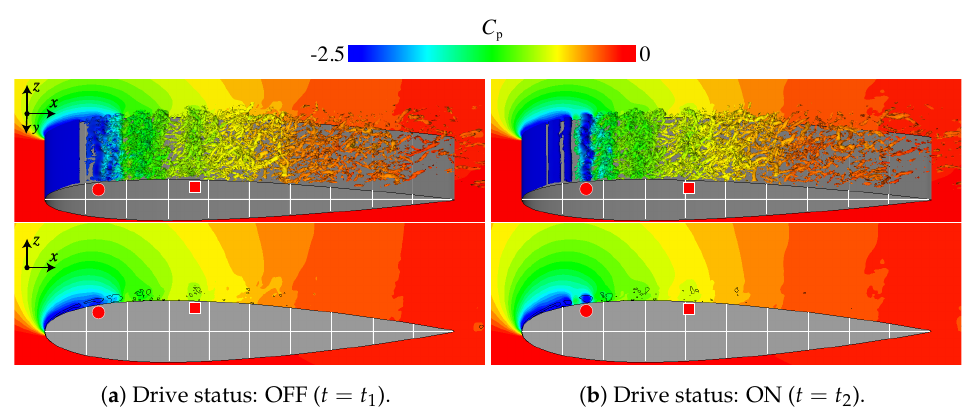
Figure 11. Instantaneous flow field (top, Q = 1250) and spanwise-averaged flow field (bottom, Q = 250) with isosurfaces of the second invariant of the velocity gradient tensor ( Q ) colored based on C p in FTM4 at α = 12. The red circles and squares denote the locations of representative spanwise vortices.